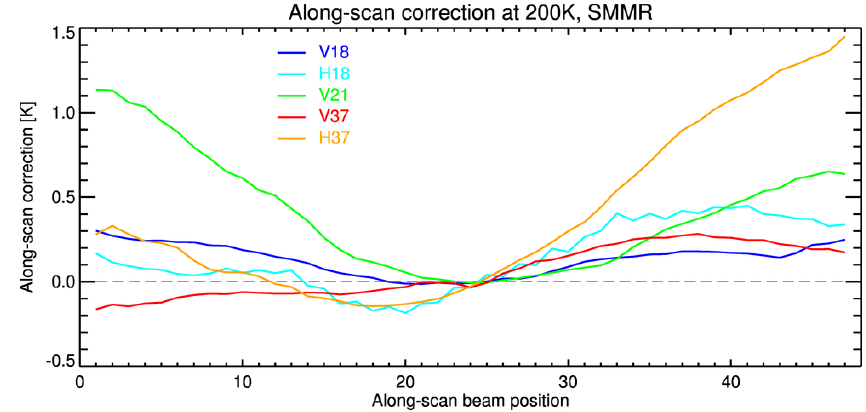
Figure 7. Scan-angle-dependent correction for the SMMR instruments. This image shows the along-scan correction at a common scene temperature of 200K. Nadir is at position 24. Channel colours are as follows: blue – v18; cyan – h18; green – v21; red – v37; orange –